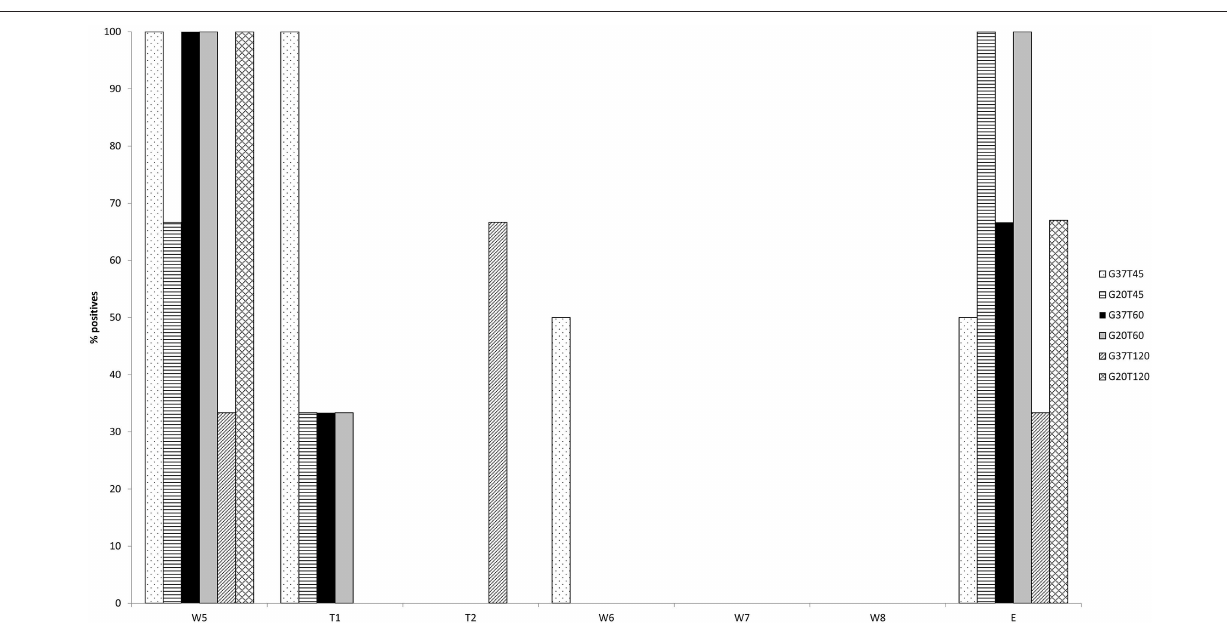
similar Cp-values ( Figure 3 ). Recipient 1047 and 1082 displayed a similar viremic profile and remained positive until 25 and 29 dpt, respectively. Cow 1052 had a shorter viremic period and was only positive until 17 dpt. All three recipient cows also displayed a very similar serological profile as they all seroconverted at 14 dpt and remained positive until the end of the experiment ( Figure 4